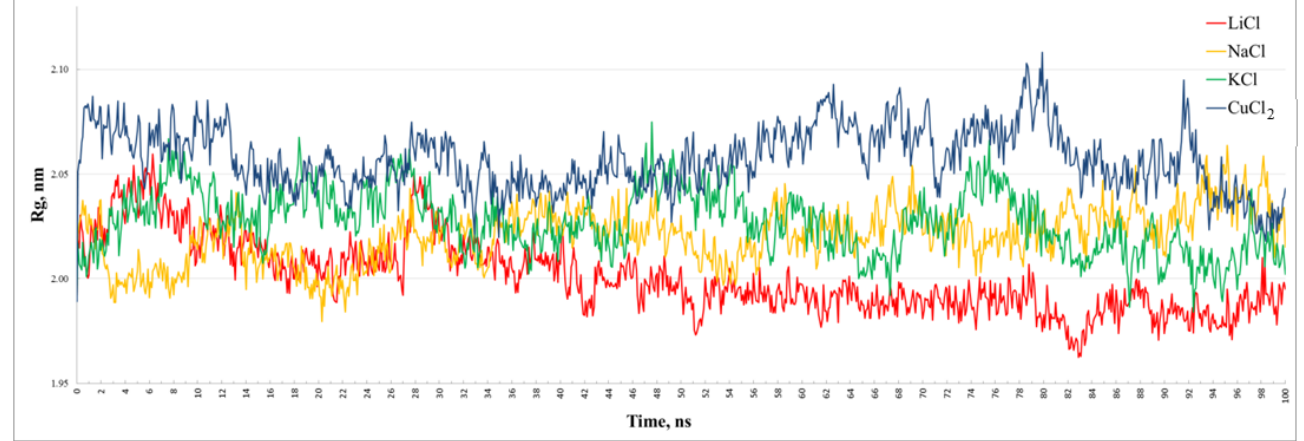
Figure 6. Radii of gyration of dimers (R g ) with different precipitants: LiCl, NaCl, KCl and CuCl 2 .